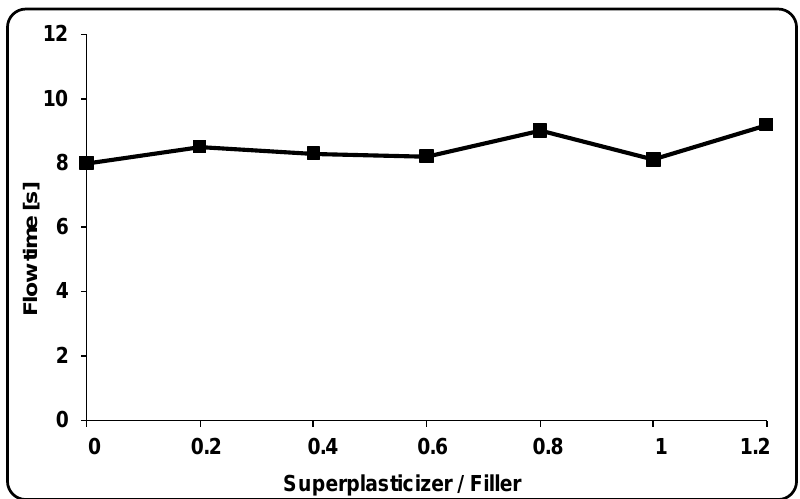
Figure 10. The flow time of marble powder–superplasticizer grout as a function of SP/marble powder ratio.